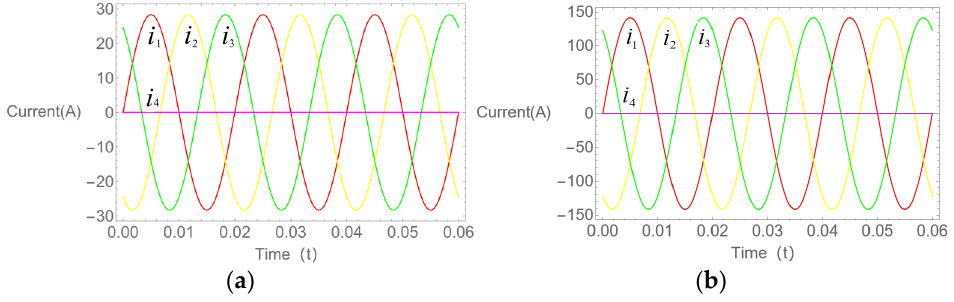
Figure 8. Schematic diagram of 16 mm 2 reduction current. ( a ) Reduction current at 20 A; ( b ) Reduction current at 100 A.